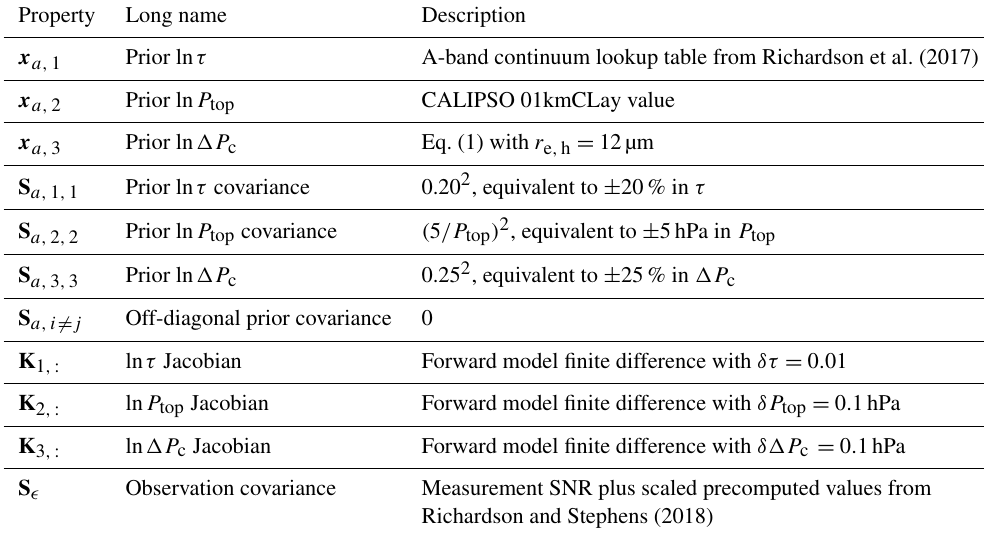
Table 1. Construction of each input vector or matrix in retrieval. Property